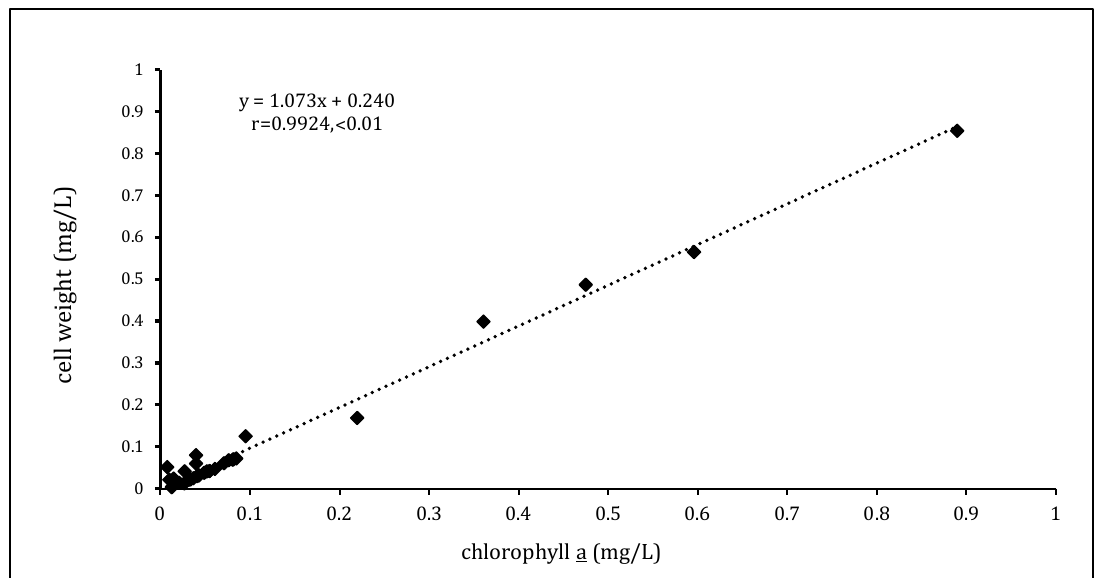
Figure 5: Correlation coefficient (r) of cell weight (mg/L) of S. platensis with chlorophyll a (mg/L) of spirulina grown in supernatant of three DRMM and Cell weight of S. platensis had highly significant (P < 0.01) direct correlation with chlorophyll a (r=0.9924) of spirulina grown in the supernatant of three different DRMM and KM during the study (Figure 5). Similarly, the total biomass of S. platensis was highly (P < 0.01) and directly correlated with chlorophyll a (r = 0.999) of spirulina cultured in the